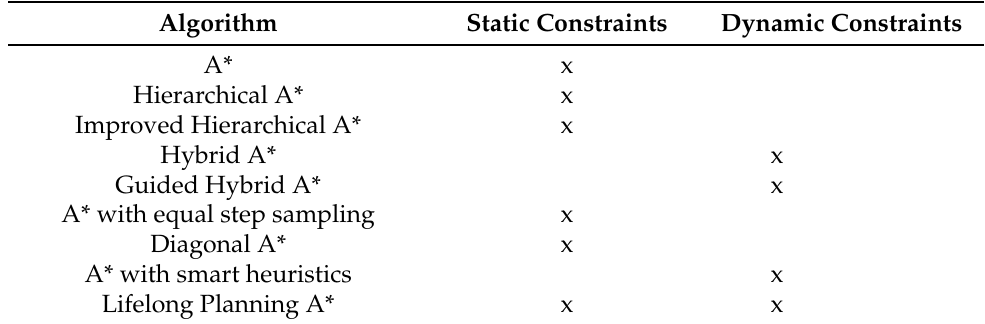
Table 3. Classification of the A* algorithm and its variants based on static and dynamic constraints.